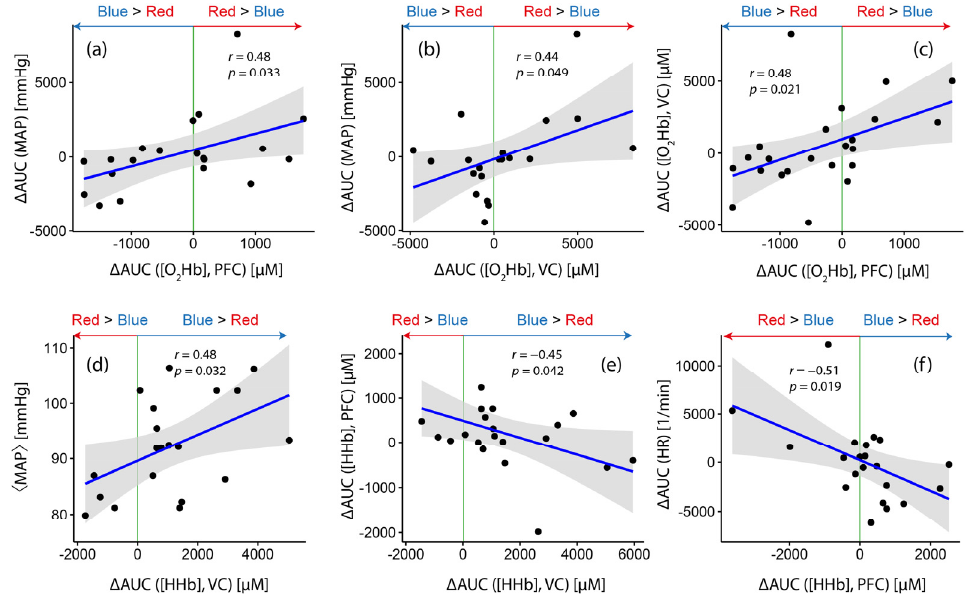
Figure 3. Correlations between ∆ AUC values from fNIRS signals and systemic physiological signals. Results of linear correlation analysis. The gray shaded areas refer to the confidence bounds of the determined correlation.